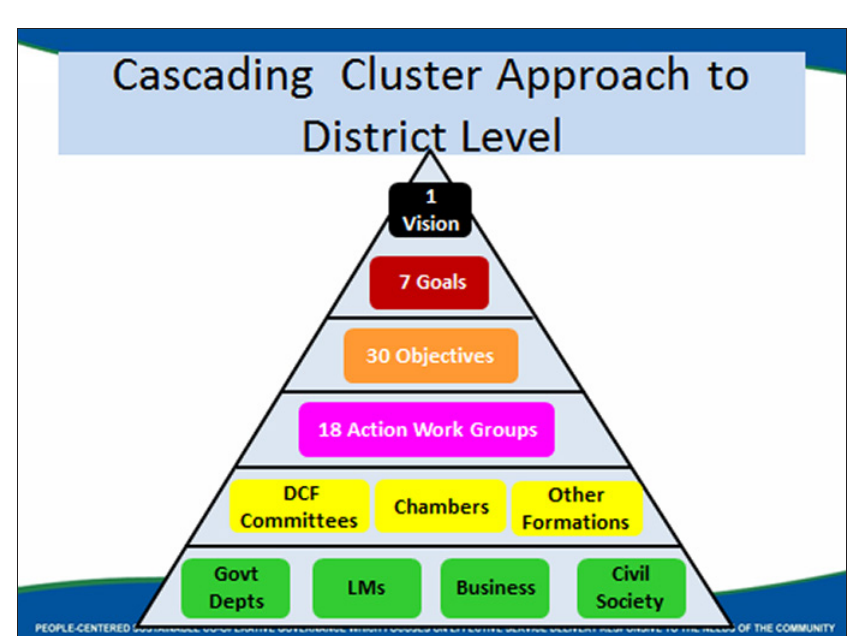
Figure 2: KZN implementation of NDP in a schematic